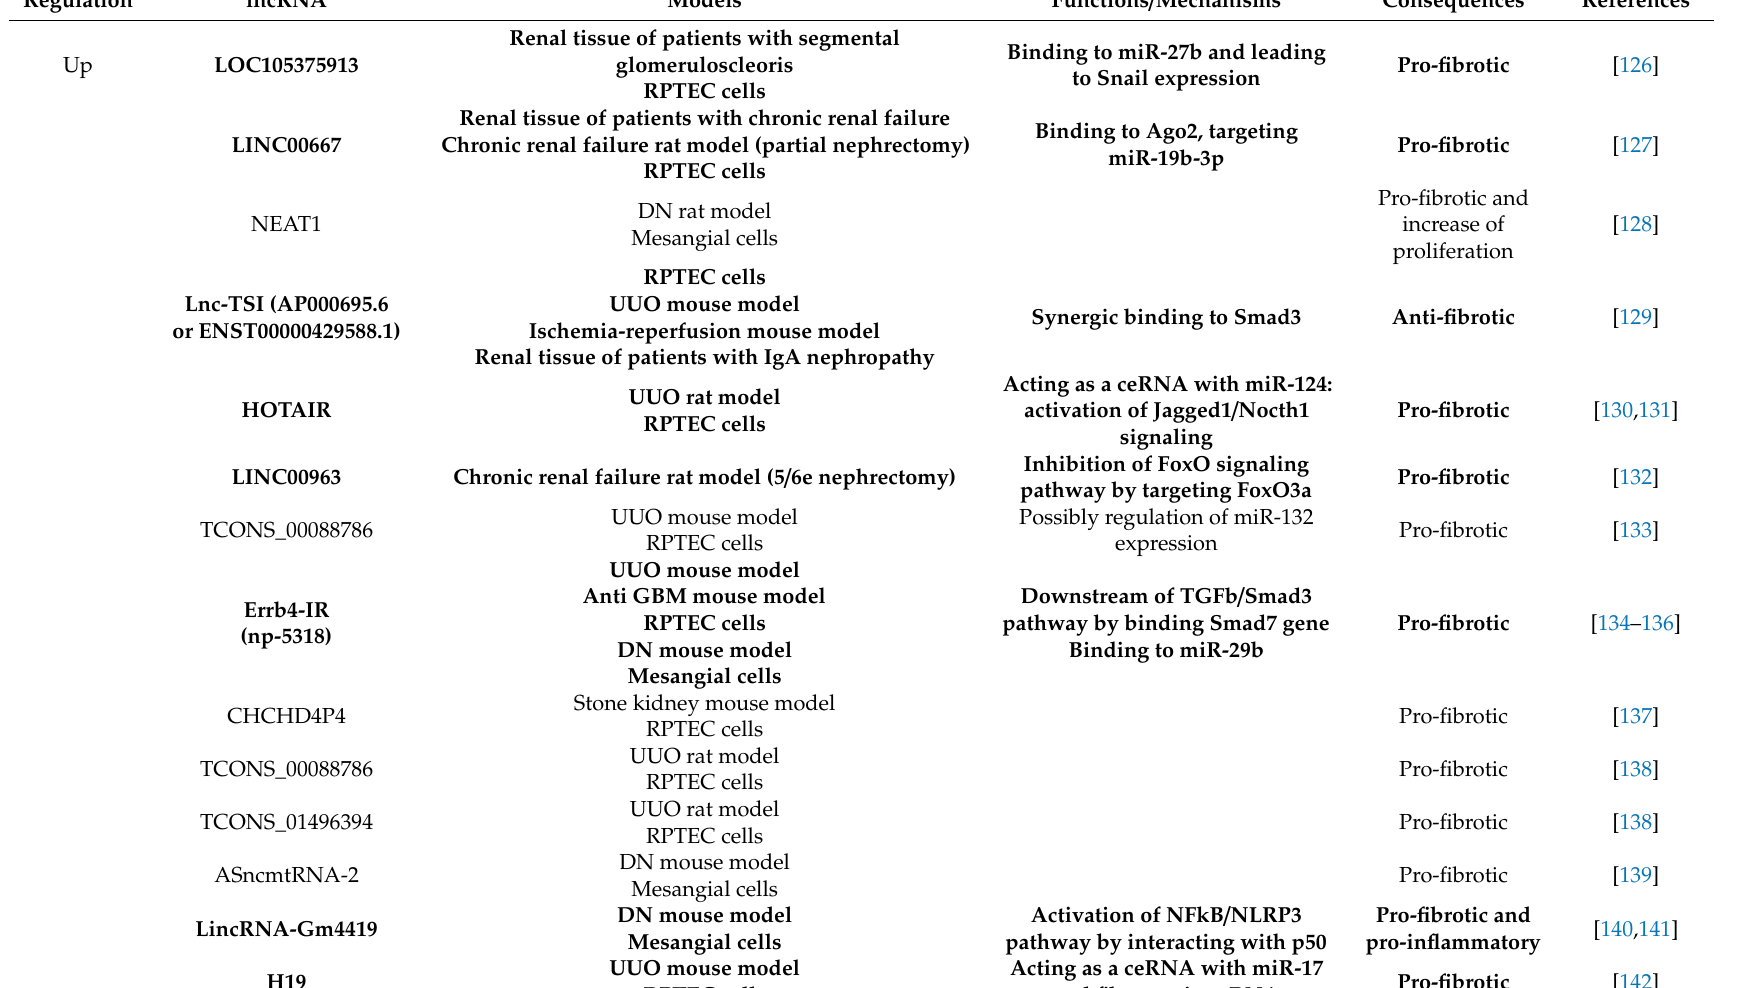
Table 2. LncRNAs involved in kidney